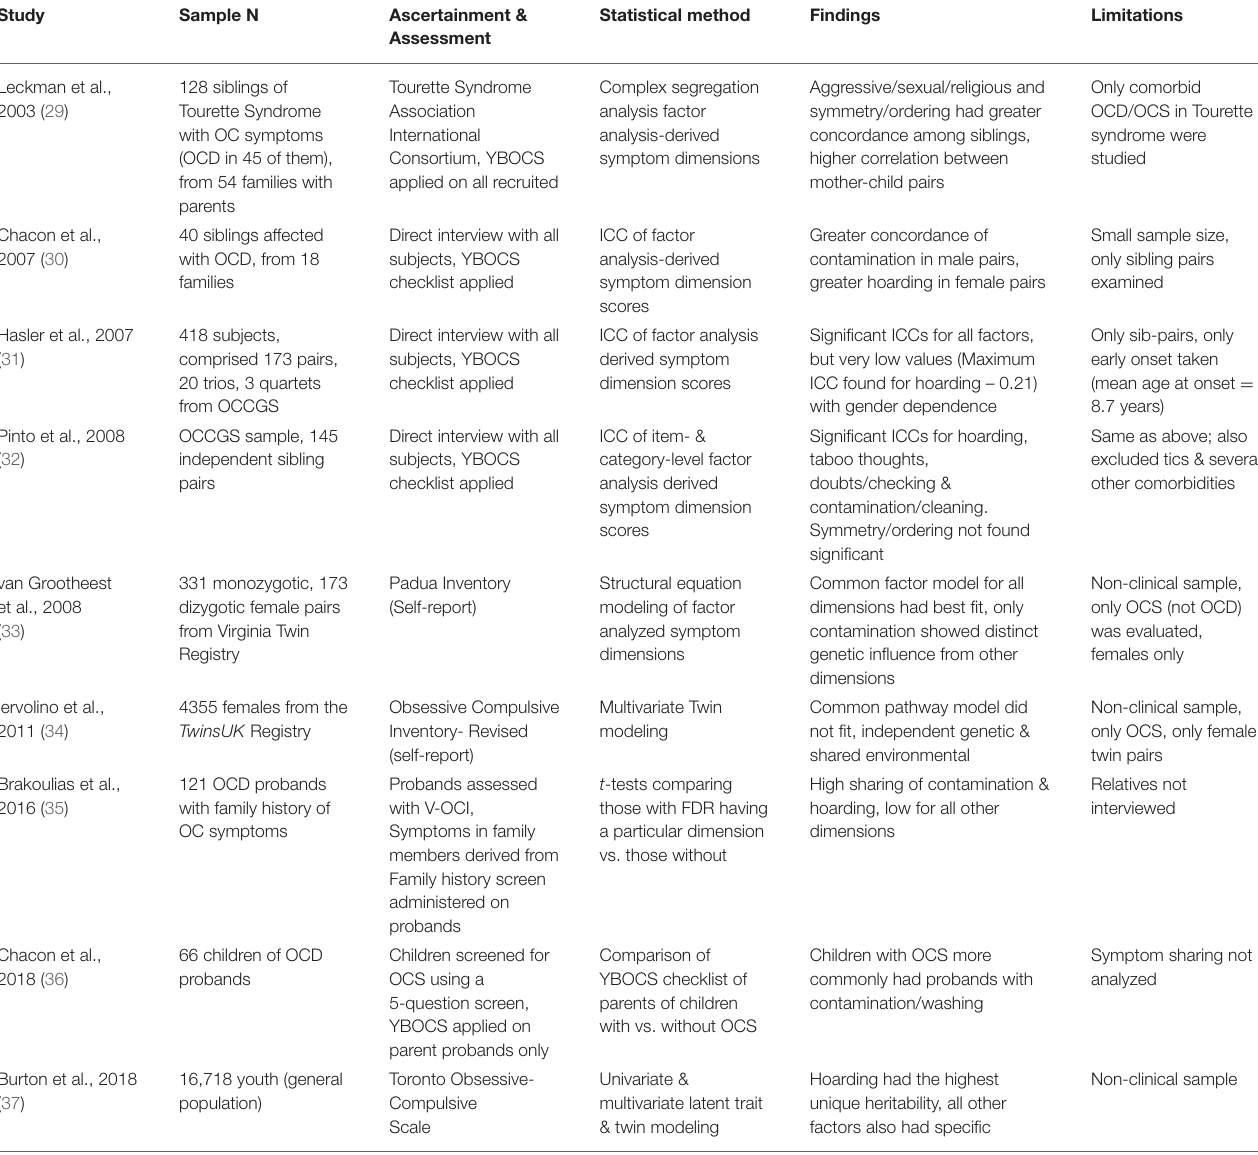
TABLE 1 | Studies that have examined familial sharing of symptom dimensions in Obsessive Compulsive Disorder